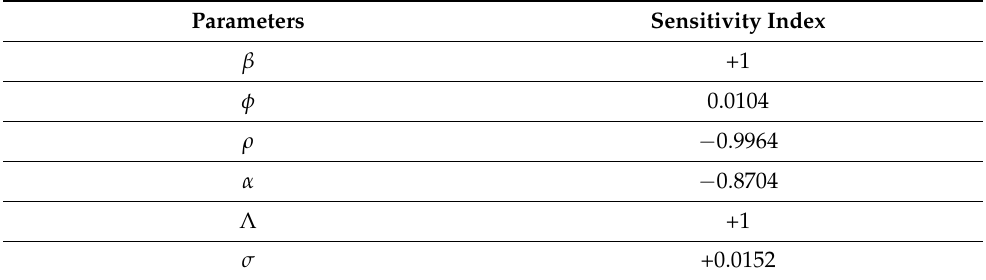
Table 3. Normalized forward sensitivity index for different parameters correspondence to Table